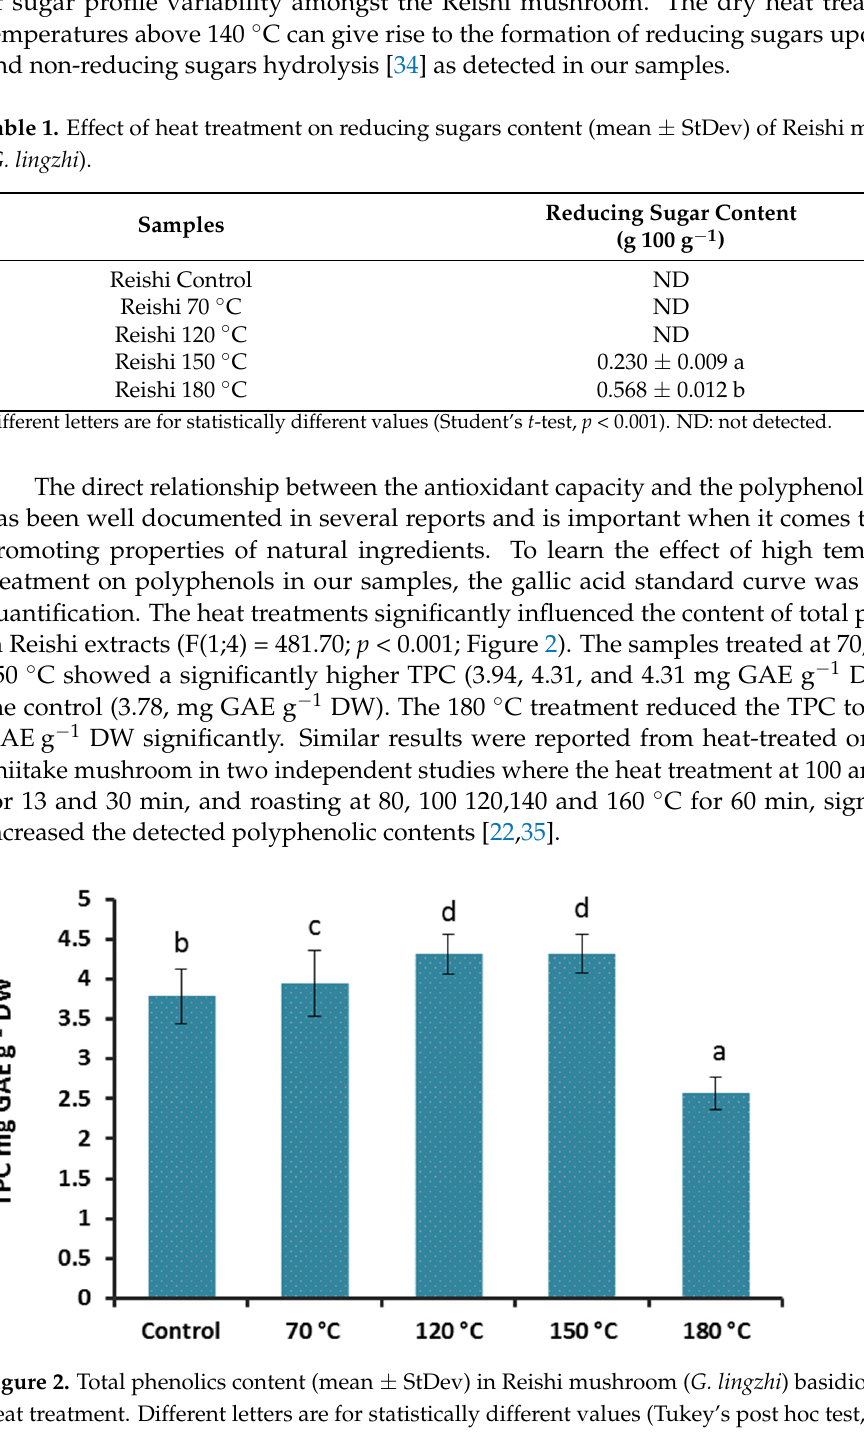
Table 1. Effect of heat treatment on reducing sugars content ( mean ± StDev) of Reishi mushroom ( G. lingzhi ).